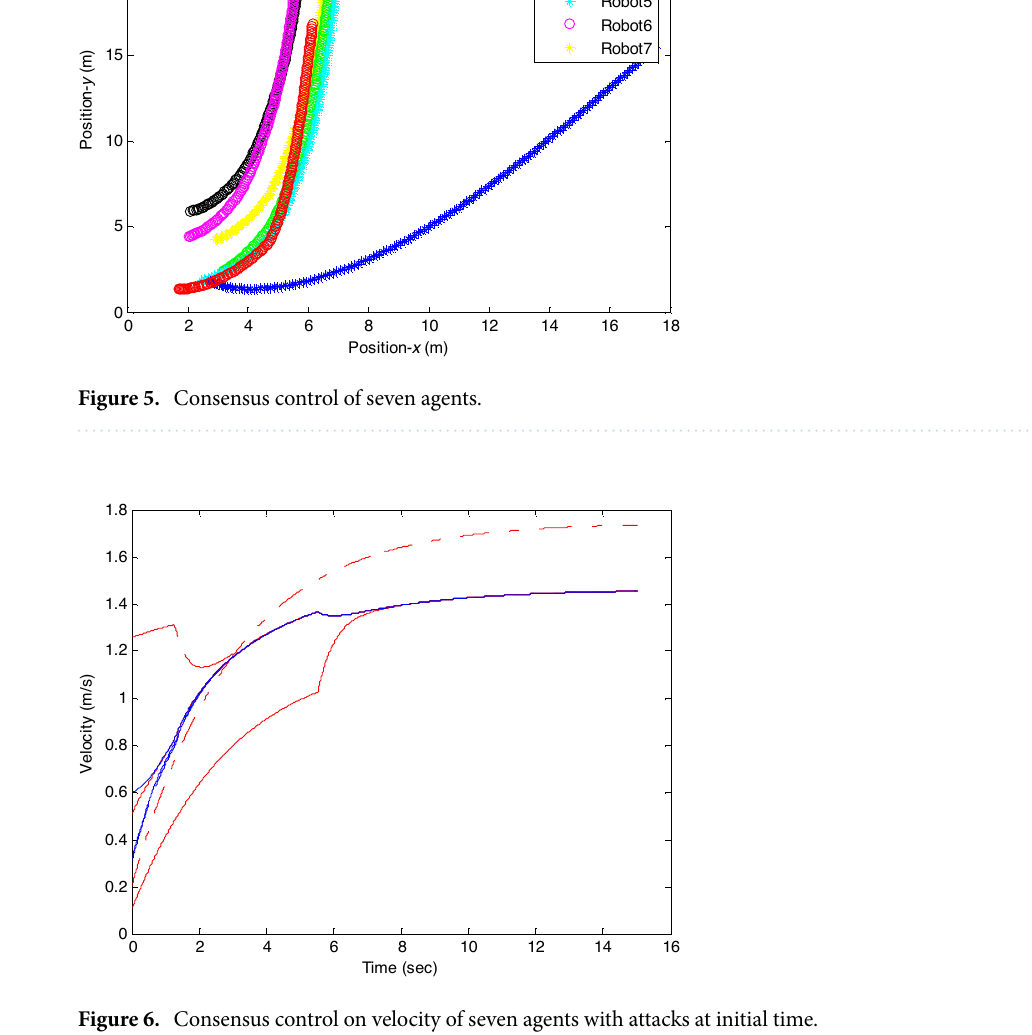
Figure 6. Consensus control on velocity of seven agents with attacks at initial